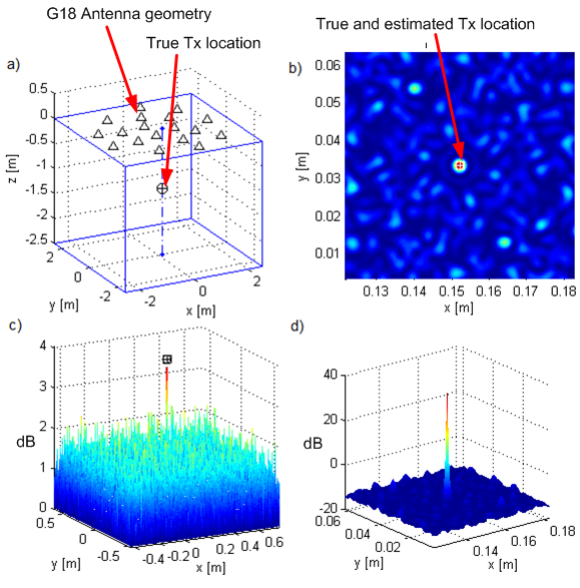
Figure 19. Results of localization for G 18 : ( a ) Rx array geometry and Tx position, ( b ) ML-US criterion function over a smaller area, ( c ) ML-US over a larger area, ( d ) SCM-MUSIC over a smaller area with the magnitude in